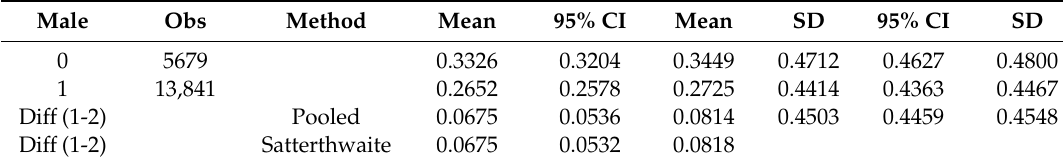
Table 2. Comparison of Success Rate between